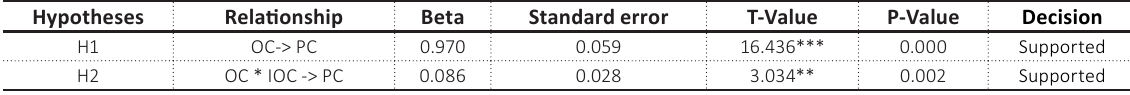
Table 5. Hypotheses testing